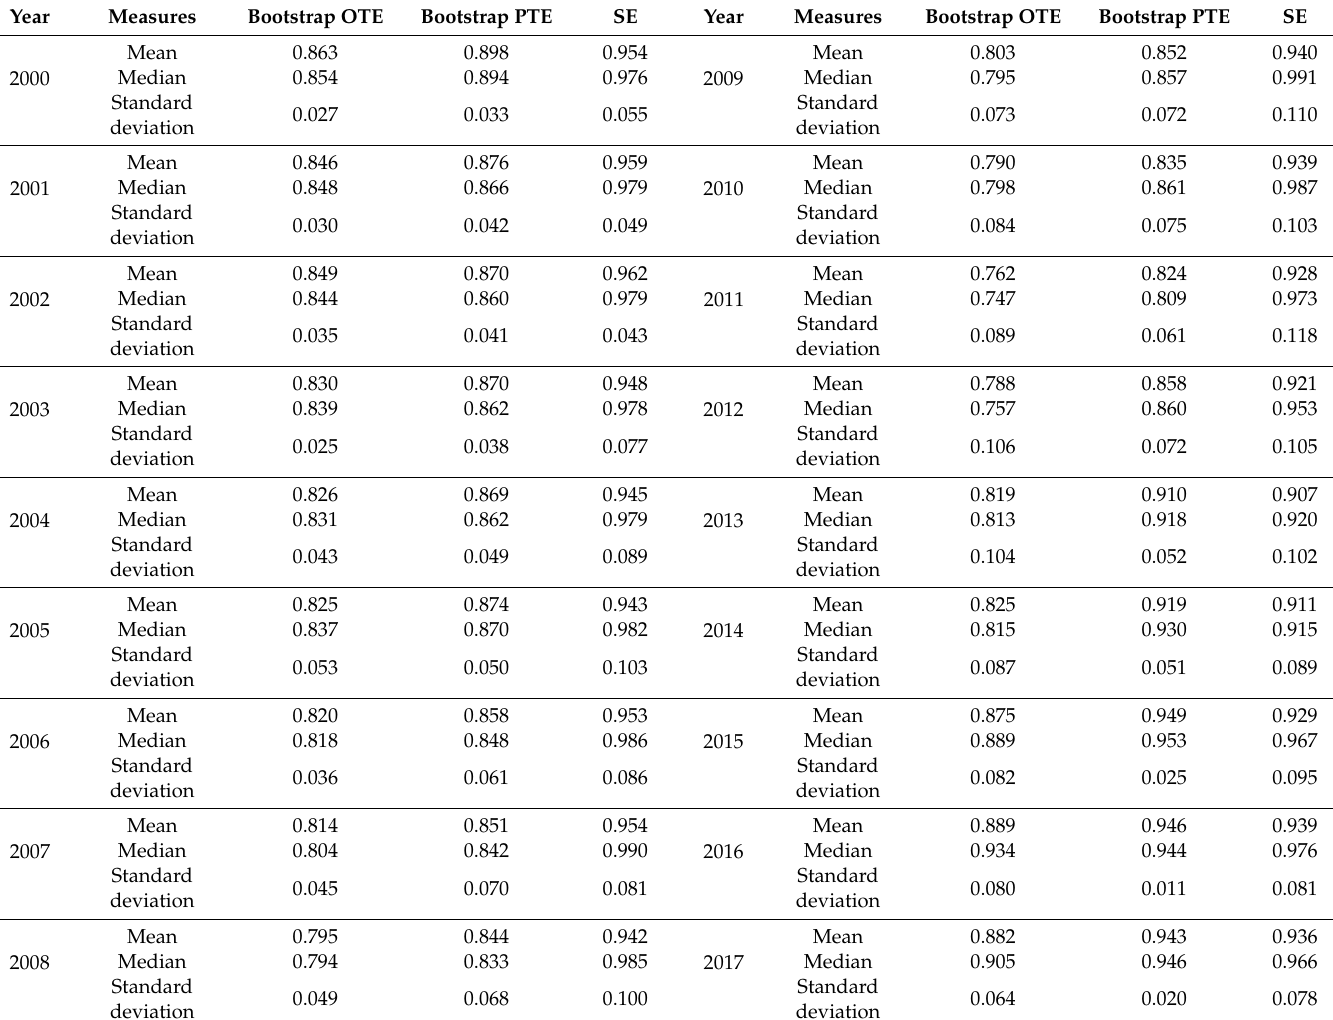
Table 2. Annual bootstrap overall technical e ffi ciency (OTE), bootstrap pure technical e ffi ciency (PTE), and the scale e ffi ciency (SE) for the first